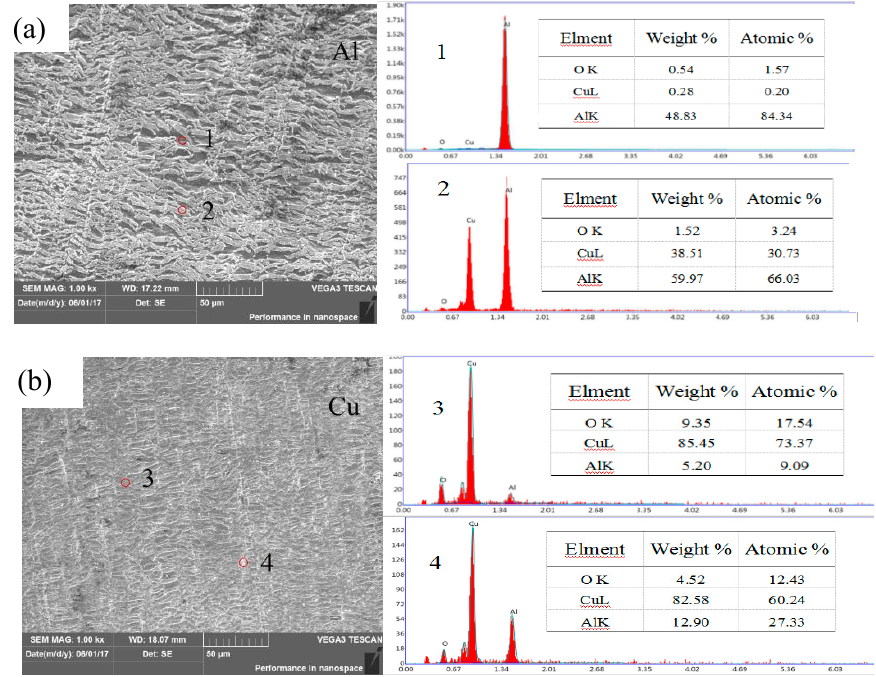
Figure 7. The structure and EDS spectra of the bonding interface in Cu/Al composite panels.